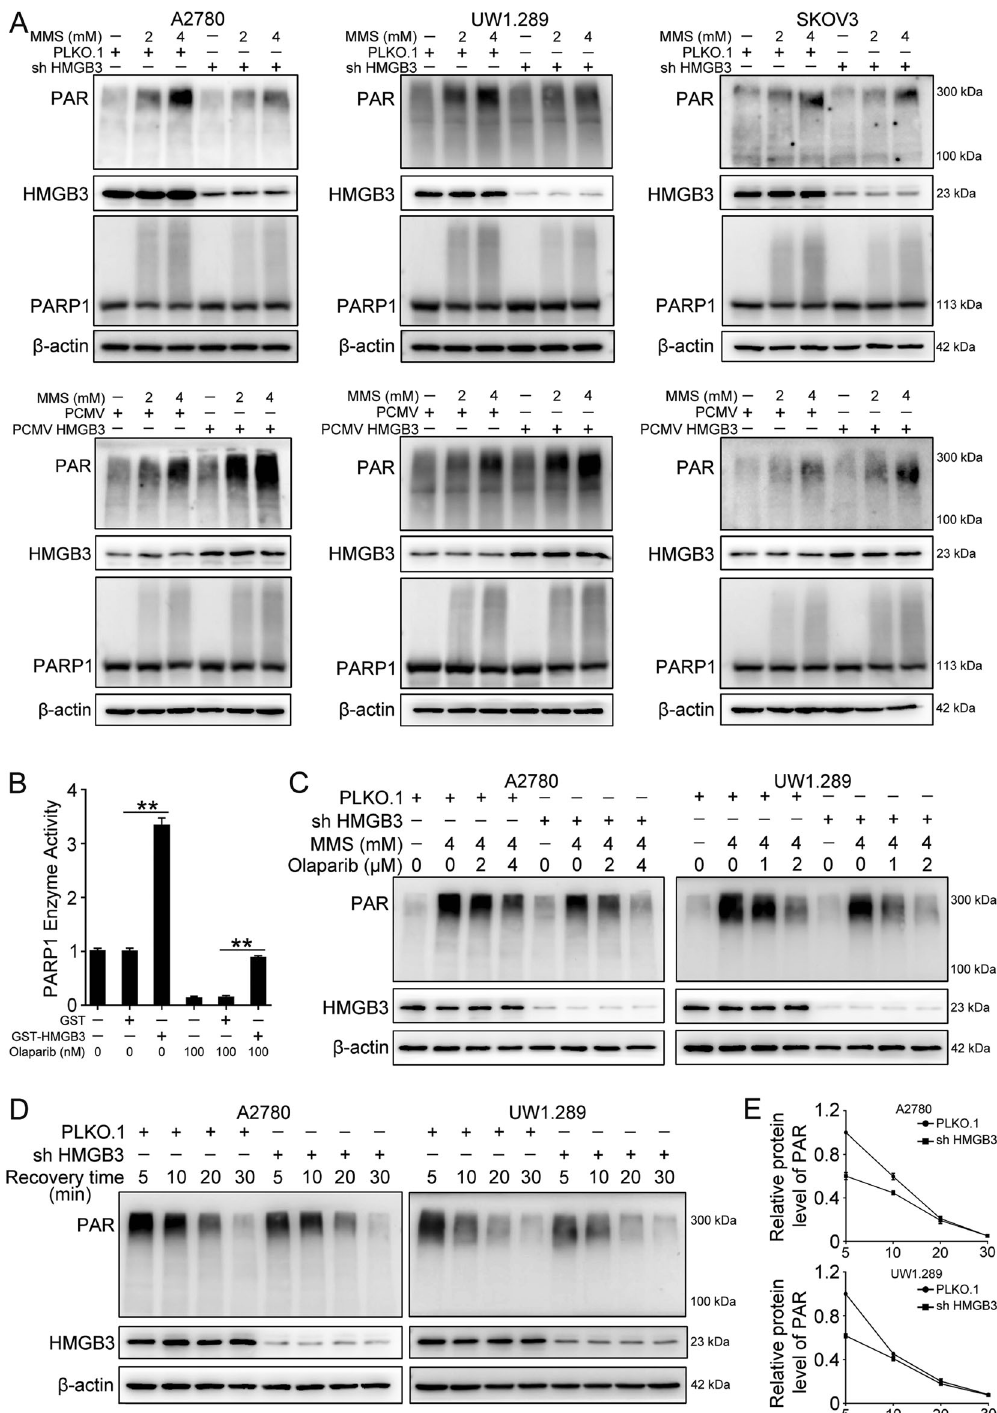
Fig. 5 HMGB3 enhances DNA damage-induced PARP1 activity (PARylation). A A2780, UWB1.289, and SKOV3 cells transfected with PLKO.1, HMGB3 shRNA (shHMGB3), PCMV, and PCMV HMGB3 were treated with 2 mM or 4 mM MMS for 20 min. Western blot was performed to detect the protein levels of PAR, HMGB3, PARP1, and β -actin. Quanti fi cation of the PAR protein levels can be found in Fig. S5A. B Activity of human recombinant PARP1 in the presence or absence of olaparib. C A2780 and UWB1.289 cells transfected with PLKO.1 and HMGB3 shRNA (shHMGB3) were treated with different concentrations of olaparib for 4 h prior to incubation with 4 mM MMS for 20 min. Western blot was conducted to detect the protein levels of PAR, HMGB3, and β -actin. Quanti fi cation of the PAR protein levels can be found in Fig. S5B. D A2780 and UWB1.289 cells transfected with PLKO.1 and HMGB3 shRNA (shHMGB3) were treated with 4 mM MMS for 20 min. The culture medium containing MMS was replaced with normal culture medium, and cell lysates were collected at de fi ned time points (5, 10, 20, and 30 min). Western blot was used to detect the protein levels of PAR, HMGB3, and β -actin. E Quanti fi cation of the PAR protein levels in ( D ). (Data are presented as the mean ± SEM, * p < 0.05, ** p < 0.01, n = 3). Cell Death and Disease (2022)